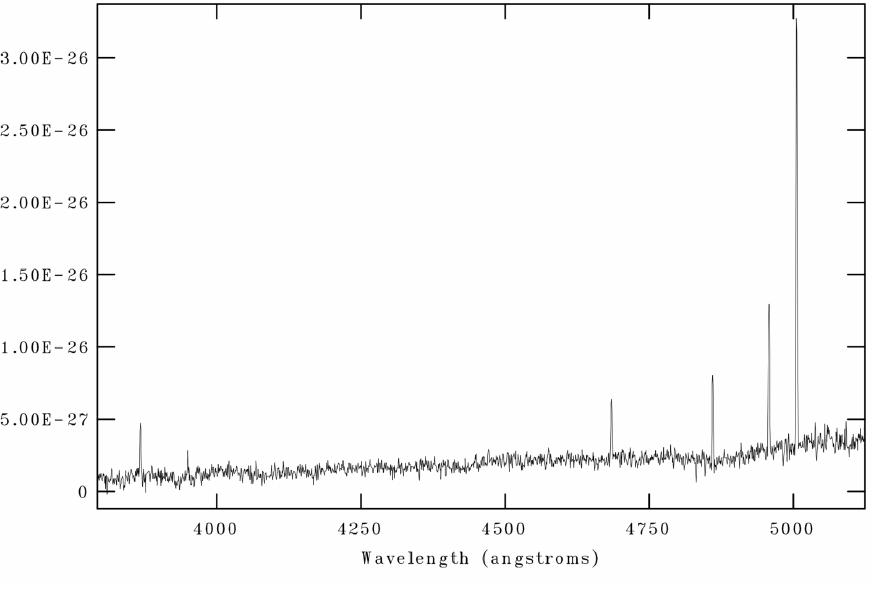
Figure 3. Our VLT FORS2 nebular blue spectrum where the HeII 4686 Å, H β emission lines and [OIII] 4959, 5007 Å doublet are clearly